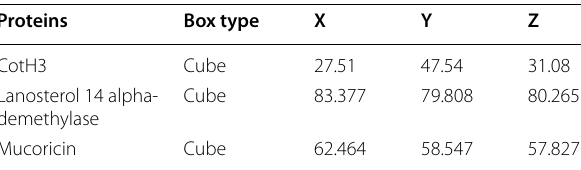
Table 2 AutoDock mediated docking parameters like box type and grid box information for our target proteins